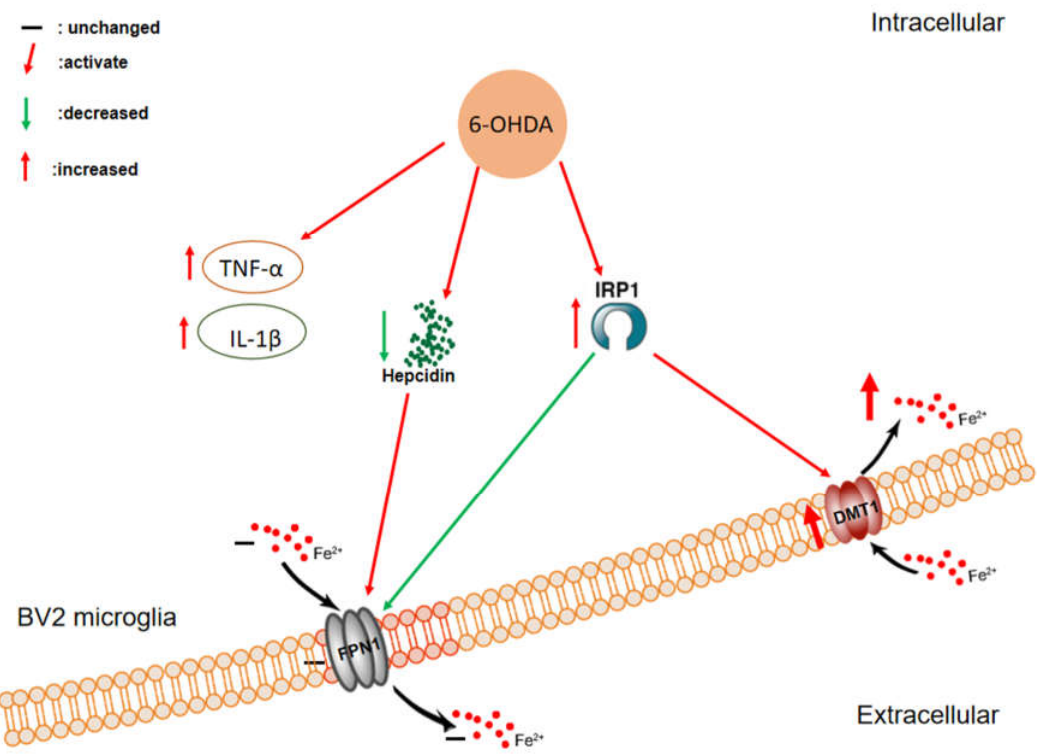
Figure 10. Graphical illustration of the effect of 6-OHDA on iron metabolism in BV2 cells.